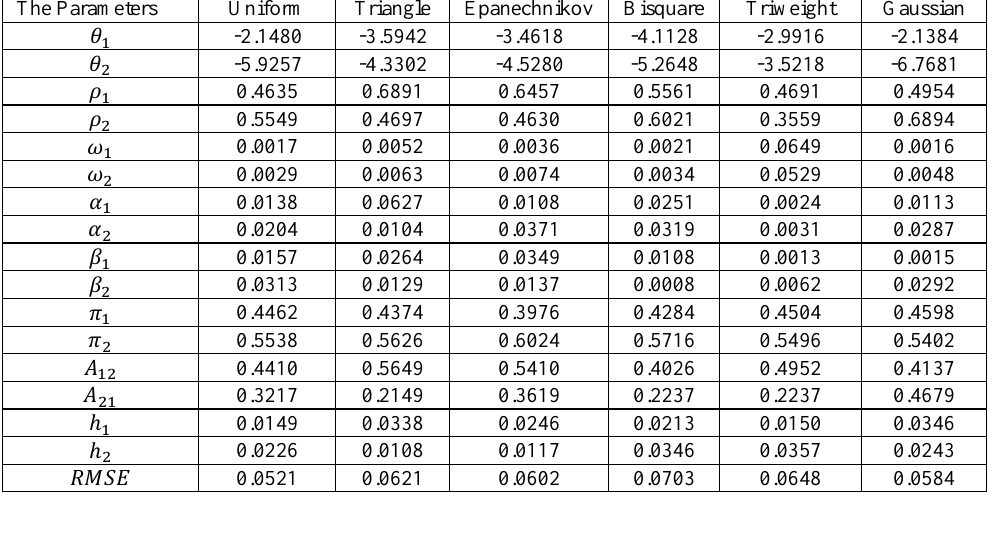
Table 3. The estimated parameters for the simulated data based on ( ) ( ) .